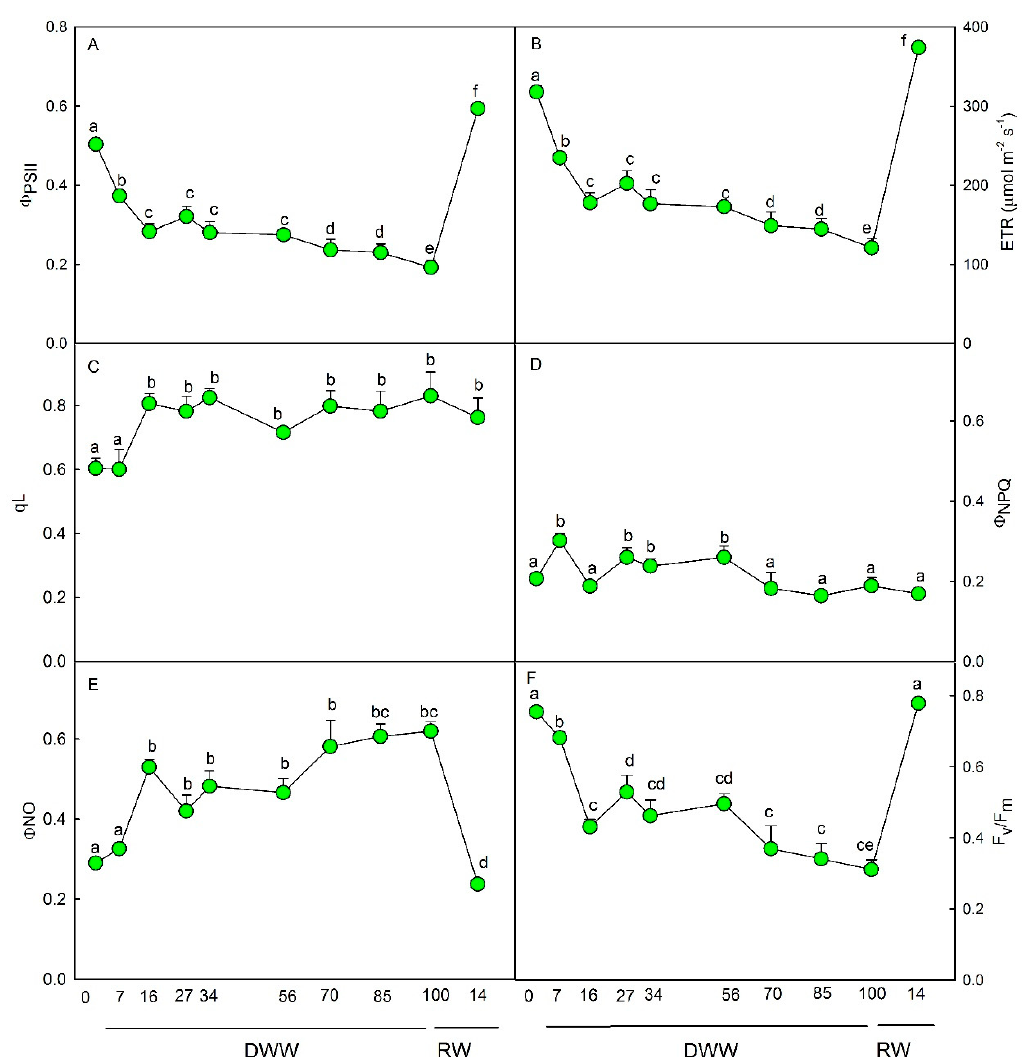
Figure 2. Trends of ( A ) quantum yield of photosystem II electron transport, Φ PSII; ( B ) electron transport rate, ETR; ( C ) photochemical quenching, qL; ( D ) yield of regulated energy dissipation, Φ NPQ; ( E ) yield of non-regulated energy dissipation, Φ NO; ( F ) maximal PSII photochemical efficiency, F v /F m , during days without water (DWW), and rewatering (RW). Different letters indicate statistically significant differences ( p ≤ 0.05) among different days. Data were analyzed by one-way ANOVA repeated measurements followed by the Tukey’s test. Data are means ( n = 10) ± SE. Photochemical indexes have been extracted at 1500 Photosynthetic Photon Flux Densities (PPFD) by rapid light curve.